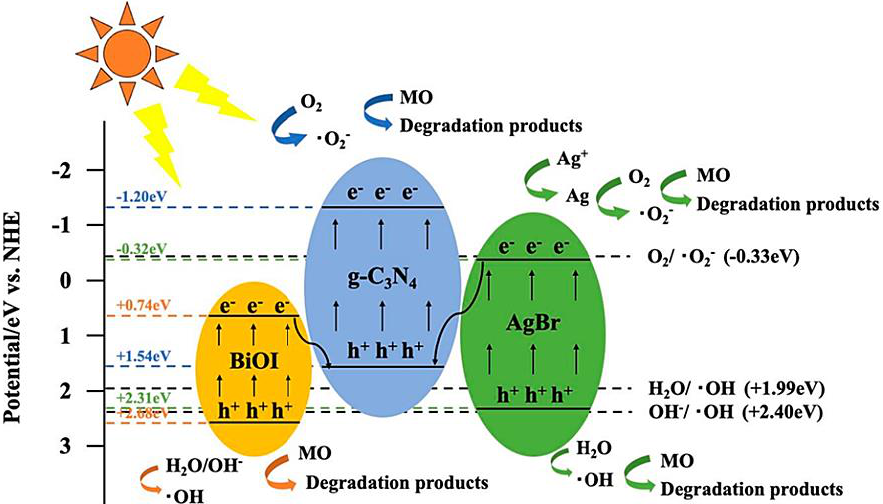
Figure 14. Double Z-type electron transfer mechanism of heterojunction for the photodegradation of MO based on AgBr/BiOI/g-C 3 N 4 . Reproduced with permission from [152]. Copyright 2022 American Chemical Society.